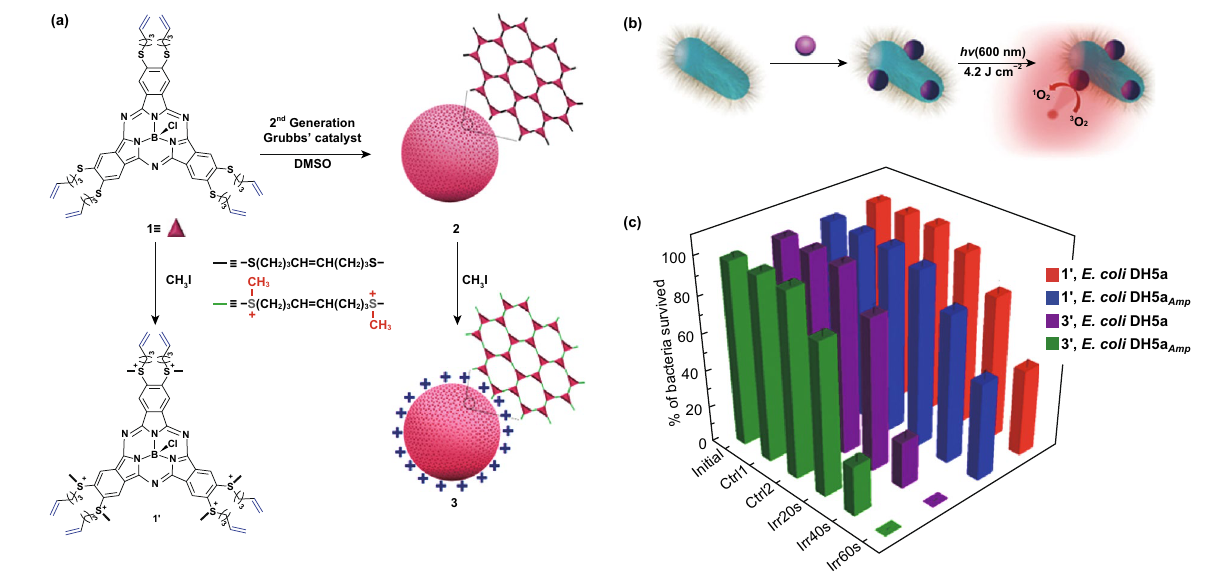
Fig. 4 a Preparation of SubPc nanosphere. b Schematic illustration of SubPc nanosphere for bacterial labeling and photoinactivation. c Photo- dynamic killing of SubPc nanosphere on E. coli DH5a and the ampicillin-resistant strain E. coli DH5aAmp. Initial: original bacteria count. Ctrl 1: dark-toxicity experiments. Ctrl 2: phototoxicity experiments. Irr20s, Irr40s, and Irr60s: the bacterial suspension after photosensitizer incuba- tion was irradiated with a laser for 20 s, 40 s, or 60 s, respectively [57]. Copyright 2015